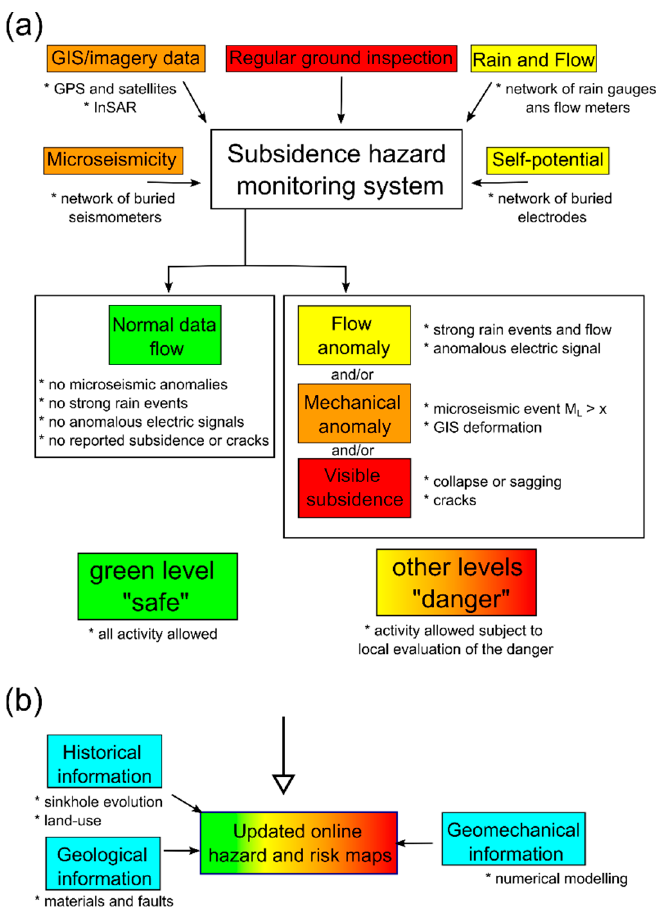
Figure 15. Schematic overview of the hazard monitoring system suggested for implementation at GAH. Typical data examples are shown in Figure 13. ( a ) In ‐ and output system with appropriate warning levels. ( b ) Further information flow for hazard and risk maps.